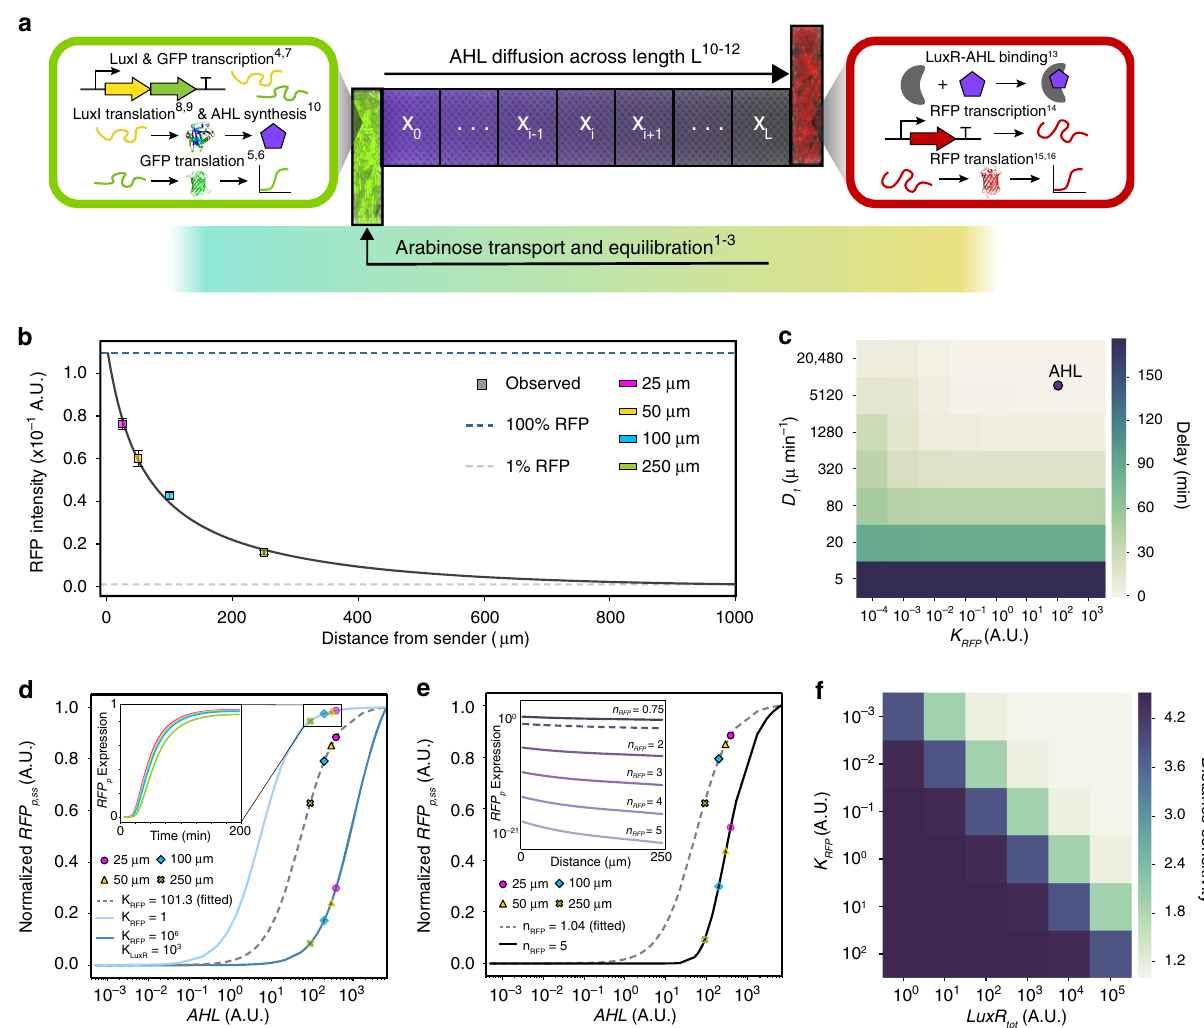
Fig. 2 Computational model of inter-strain communication in de fi ned spatial environments. a Model schematic depicting the physical and biological processes represented by the model equations (Supplementary Methods). b The model RFP p steady-states decrease with the distance from the sender strain. The blue dashed line represents the maximum RFP p steady-state concentration for a 2 μ m interaction channel. The gray dashed line denotes 1% of the maximum steady-state RFP p concentration. Data points (squares) represent experimental measurements and error bars denote 1 SD from the mean. c Heat map of the simulated RFP p time delays for diffusible signal molecules spanning a broad range of diffusion rates ( D 1 ) and binding af fi nities of LuxRAHL to the RFP K RFP p promoter ( RFP ). The circle represents the estimated parameters based on experimental data. d p steady-state dose response as a function of AHL for different K RFP and K LuxR values. The dashed curve represents the dose response of the parameterized model based on the experimental data. Inset denotes representative simulations of RFP p for different interaction channel lengths. The RFP p steady states for each interaction channel length (colored marker styles) were computed for ara = 10. e Steady-state RFP p dose response as a function of AHL for two different n RFP values in the model. The dashed curve represents the dose response for the parameterized model based on experimental data. The RFP p steady-states for each interaction channel length (colored marker styles) were computed for ara = 10. Inset: relationship between distance and steady-state RFP p concentration for a range of n RFP values. f Heatmap of distance sensitivity across a broad range of total LuxR concentrations ( LuxR tot ) and binding af fi nities of the activated LuxR complex to the RFP p promoter ( K RFP ). Distance sensitivity is de fi ned as the ratio of steady-state RFP p concentration in a 25 – 250 μ m condition. Source data are provided as a Source Data fi